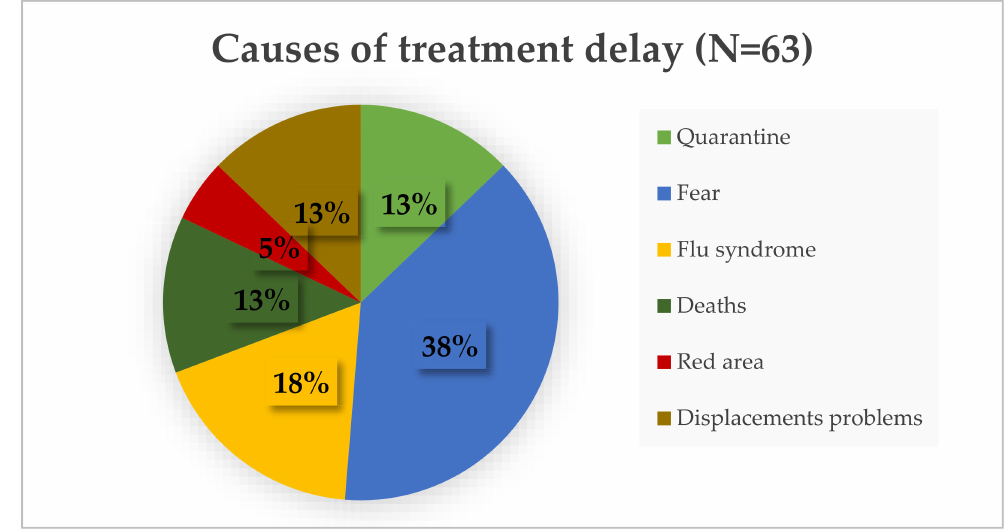
Figure 3. The image shows the COVID-related causes of treatment delay in